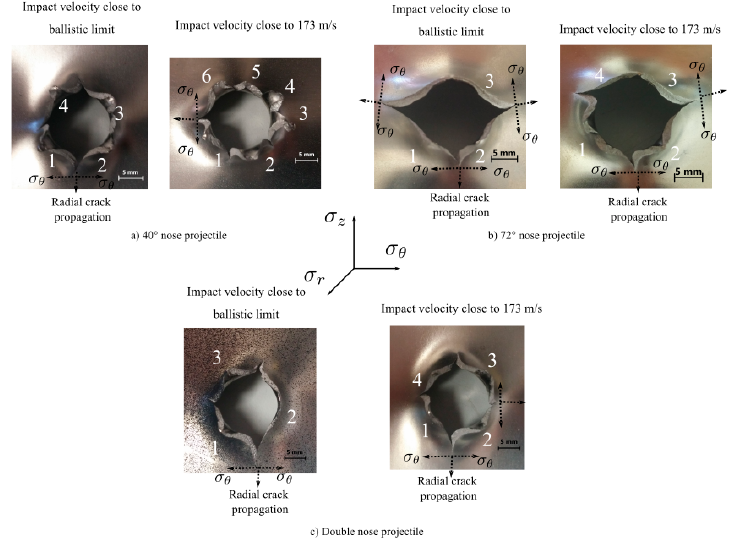
Figure 6. Specimen final stage under different nose-shaped projectile impact.